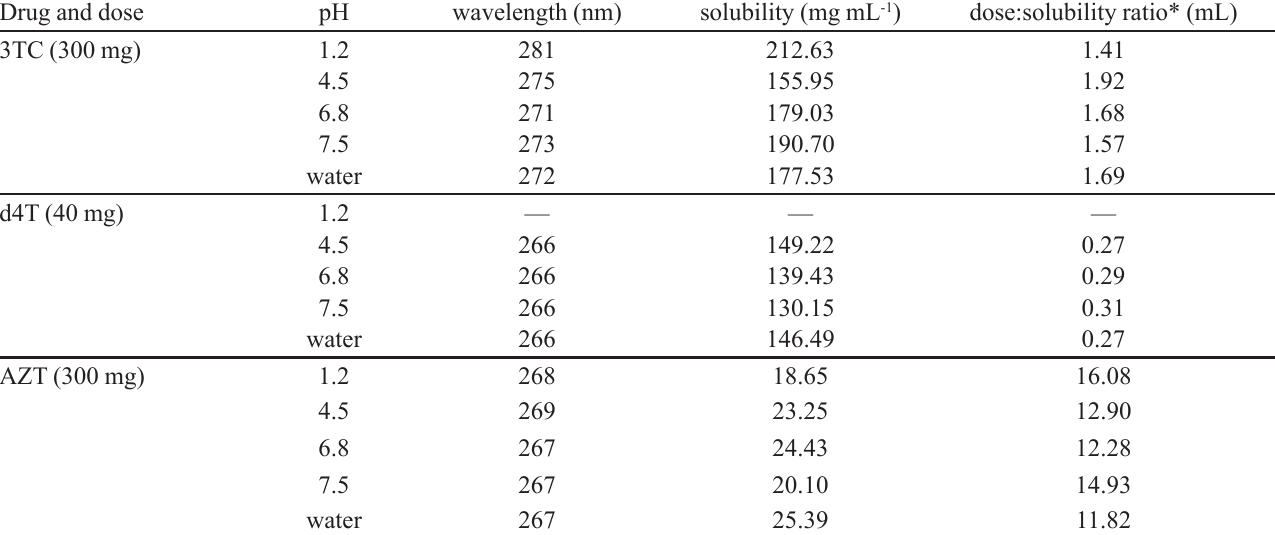
TABLE II - Solubility at 37 °C and dose:solubility ratio of 3TC, d4T and AZT for each media used obtained through equilibrium method